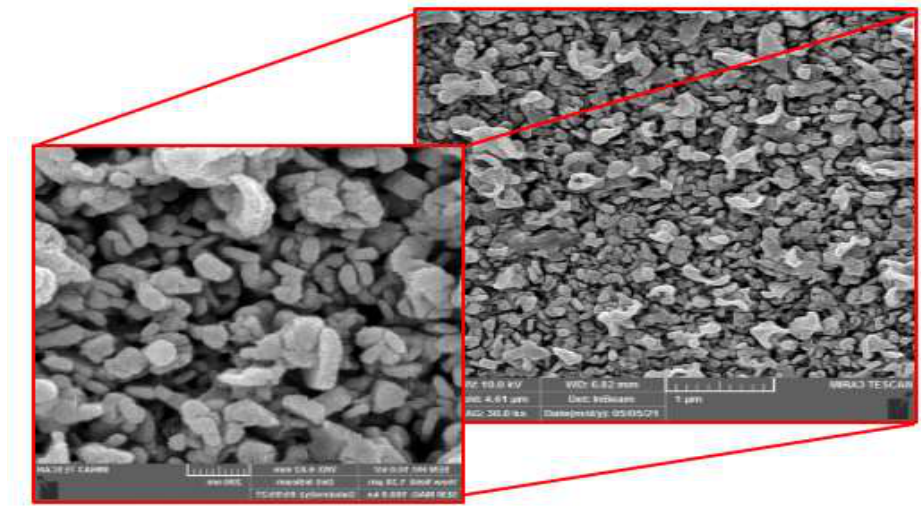
Figure7b .SEM images for PbI2 thin film surfaces on porous